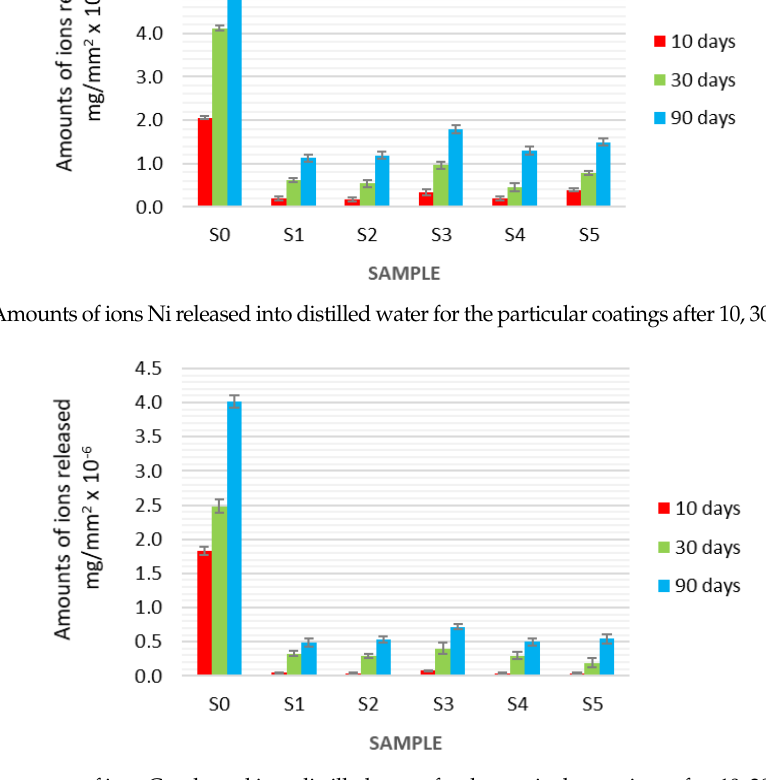
Figure 4. Amounts of ions Cr released into distilled water for the particular coatings after 10, 30, and 90